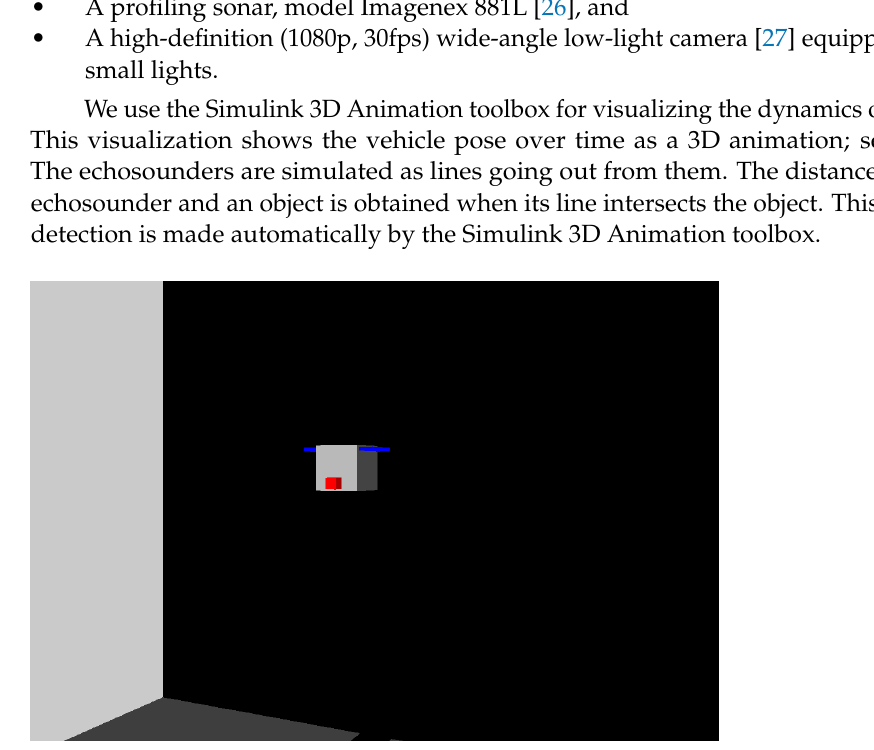
Figure 11. Visualization of the 3D model of the vehicle and the scenario. The red dot in front of the simulated vehicle is an allusion to the red of the Imagenex Profiling Sonar 881L. The blue lines on both sides are the representation of the “wings” carrying the propellers on VITA1. The side wall and floor of the simulated tunnel can be seen in gray and dark gray, respectively, on the